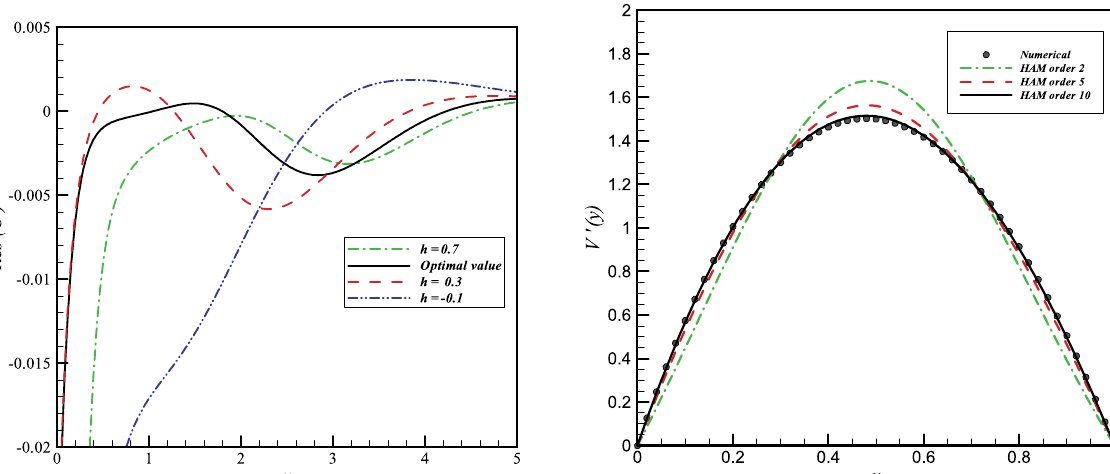
Fig. 7. Comparison of V (cid:2) ( y ) obtained by various orders of the HAM with numerical solution, when Re = 1 . 0 and Ha = 1 . 0 ,